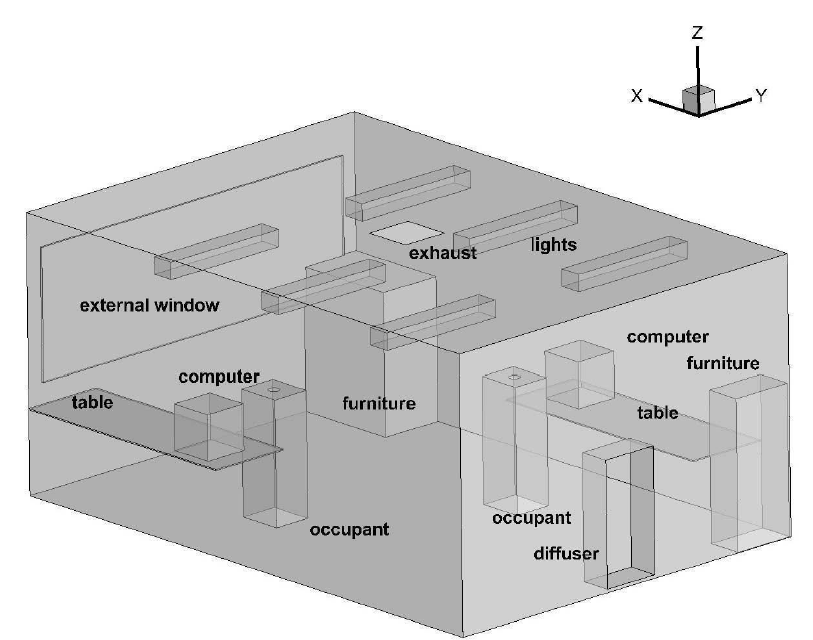
Figure 3. The 3D office